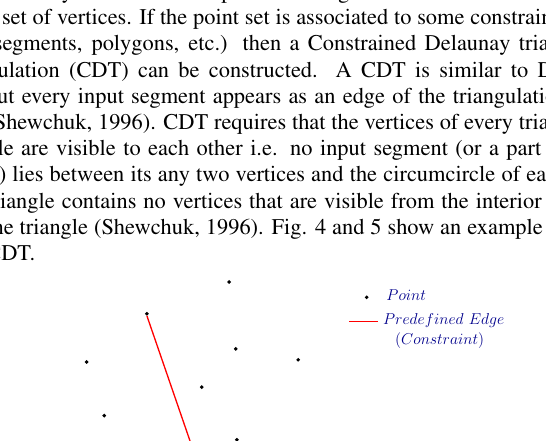
Figure 1: Tiling of TIN